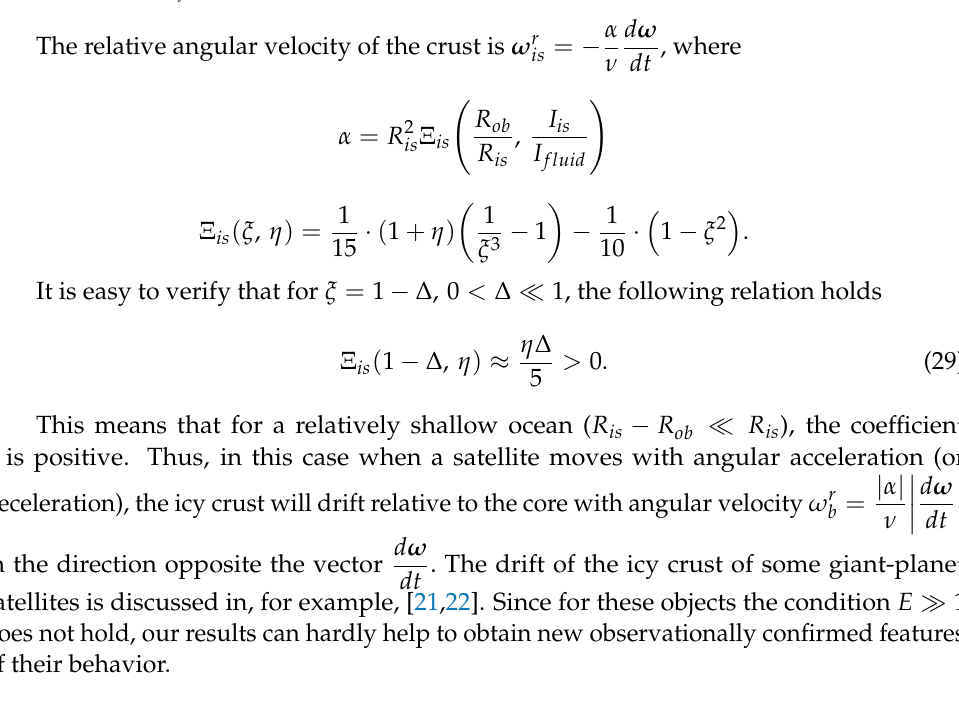
Figure 4. Distribution of velocities in the ocean: lines of equal velocity magnitude in a plane through the instantaneous axis of relative rotation of the icy crust (which is the flow’s axis of symmetry) for R ob / R is = 0.7, I is / I fluid = 0.05, α ≈